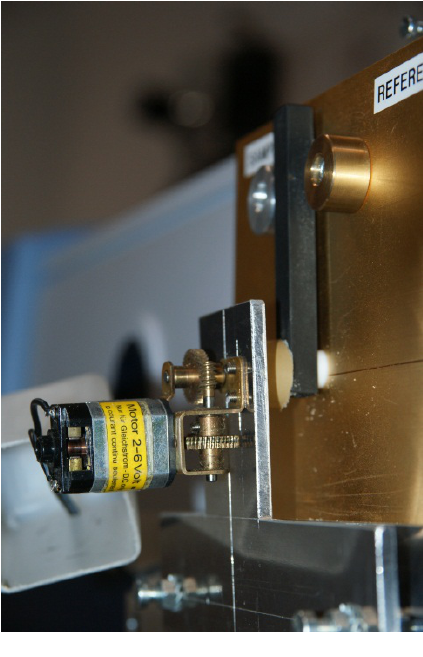
Figure 3. Detail of folding mirror lever with switching